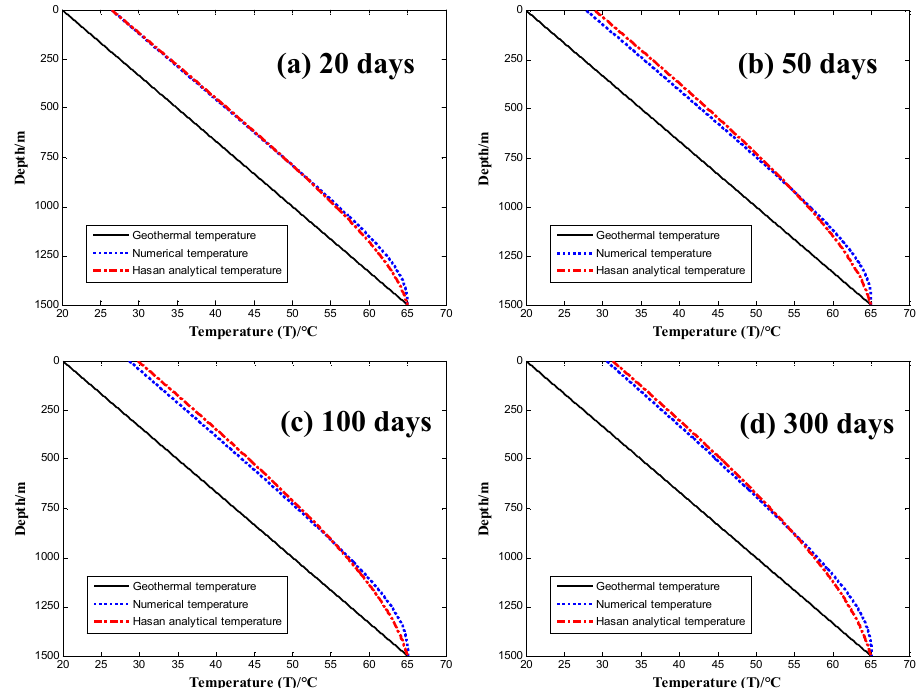
Figure 8. Comparison of the temperature profile of the proposed model with a Hasan analytical solution at different production times. (a), (b), (c), (d) are the temperature profiles of 20, 50, 100, 300 days of production time, respectively.